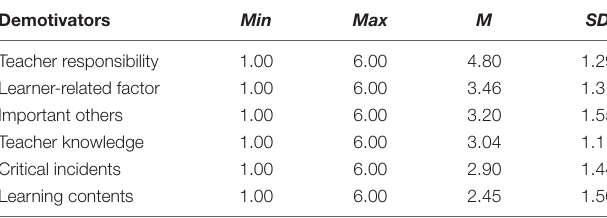
TABLE 4 | The descriptive statistics of the levels of English learning